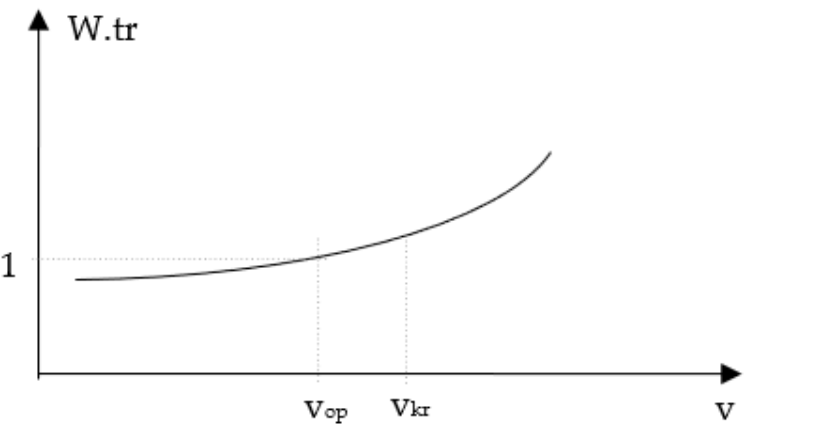
Figure 3. Dependence of the difficulty coefficient on velocity (v op -optimal velocity, v kr -critical velocity).